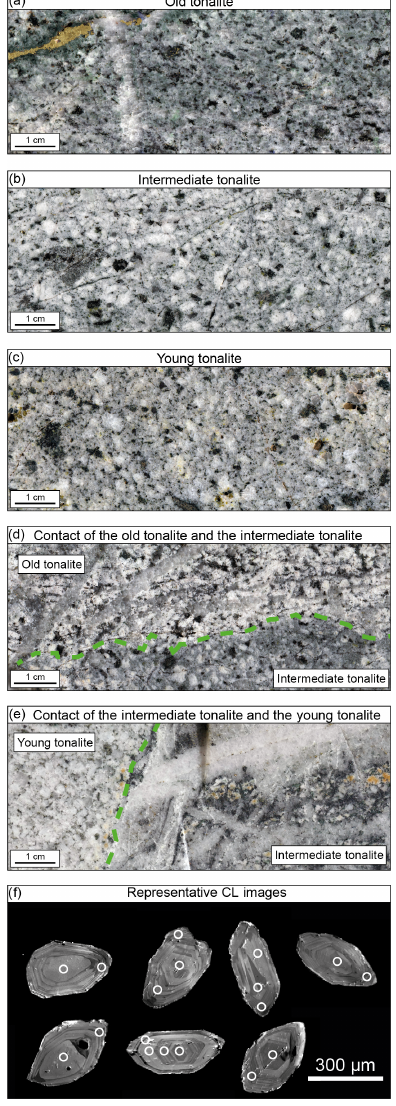
Figure 3. Rock specimens of the different tonalite porphyries and zircon CL images at Batu Hijau. Mineral assemblage in all tonalites is dominated by plagioclase, quartz and biotite. (a) Phe- nocrysts in the slightly propylitically altered, pre- to syn-Cu–Au- mineralisation, equigranular old tonalite are < 3mm. (b) Phe- nocrysts of the syn-Cu–Au-mineralisation, porphyritic intermedi- ate tonalite are < 5mm. (c) The post-mineralisation porphyritic young tonalite contains the largest phenocrysts ( < 8mm) and is characterised by a higher abundance of “quartz eyes”. (d) Abun- dant veins in the equigranular old tonalite are truncated by the later porphyritic intermediate tonalite. (e) Strongly veined intermediate tonalite is truncated by the barren and little-altered young tonalite. Dashed-green lines indicate intrusive contacts. (f) Representative zircons that display dominant oscillatory zoning and areas with little zoning. Circles indicate domains selected for LA-ICP-MS analyses (30µm in